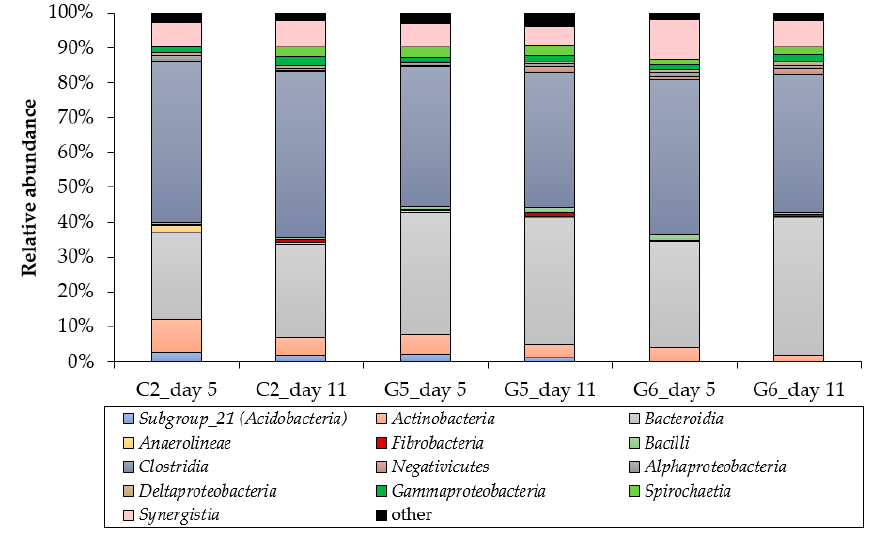
Figure 5. Taxonomic composition of bacterial communities in reactors C2, G5, and G6 (sampled on days 5 and 11). Bacterial community composition according to amplicon sequencing of the bacterial 16S rRNA gene is shown on the class level. Only classes with a relative abundance of at least 1% in at least one sample are